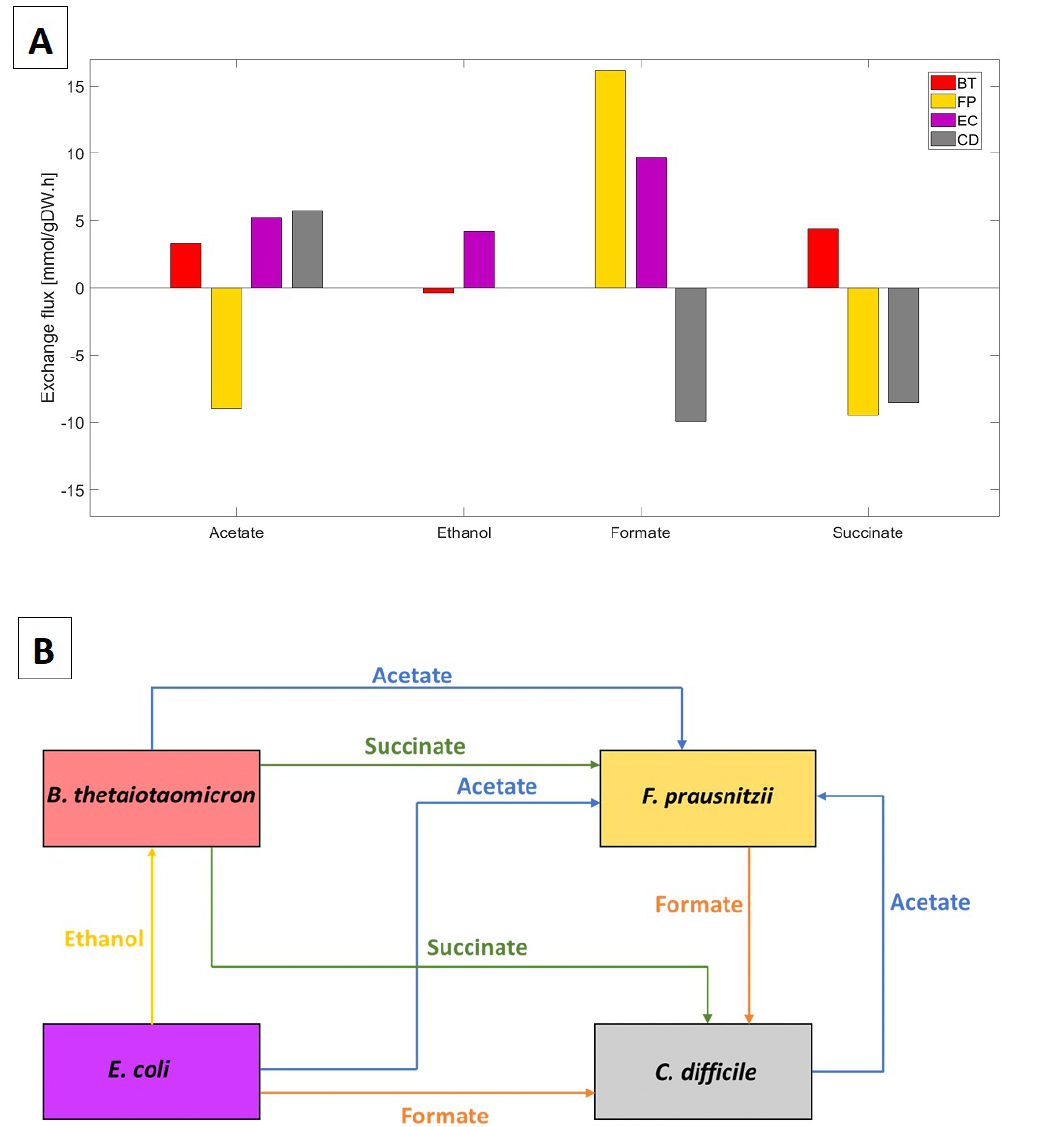
Figure 1. Predicted cross-feeding of byproducts between the four species. ( A ) Species exchange rates specified in mmol/gDW/h. Secretion rates are positive, and uptake rates are negative. ( B ) Byproduct cross-feeding patterns identified from the species uptake and secretion fluxes in